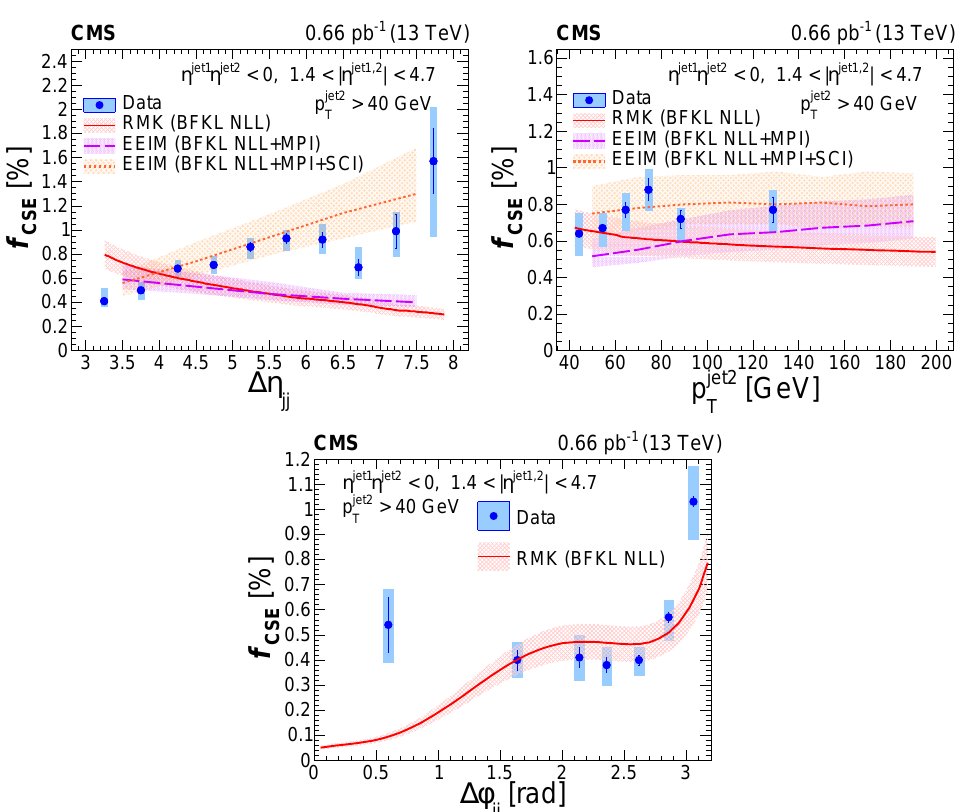
Figure 2: Fraction of color-singlet exchange dijet events, f , measured as a function CSE (cid:112) s = 13 TeV. The vertical bars represent of ∆ η , p jet2 , and ∆ φ in pp collisions at jj jj T statistical uncertainties, while boxes represent the combination of statistical and sys- tematic uncertainties in quadrature. The results are plotted at the mean values of ∆ η , p jet2 , and ∆ φ in the bin. For a given plot of f versus a kinematic variable of jj jj CSE T interest ( p jet2 , ∆ η , or ∆ φ ), the other kinematic variables are integrated over their jj jj T allowed range. The red solid curve corresponds to predictions based on the RMK model [ 9,10 ] with gap survival probability of | S | 2 = 10%. The EEIM model [ 11,12 ] predictions with MPI-only contributions and | S | 2 = 1.2% or MPI + SCI are represented by the purple dashed and orange dotted curves, respectively. The bands around the curves represent the associated theoretical uncertainties. The EEIM model has only small contributions far from back-to-back jets since no hard NLO 2 → 3 processes are included, and thus predictions are not shown for the lower panel of f versus CSE ∆ φ . The figure is extracted from Ref. [ 1 ] jj